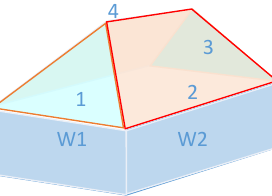
Figure 11. A building model with hip roof structure (the numbers 1 to 4 represent the individuals Pra1 , Pra2 , Pra3 and Pra4 . W1 and W2 are the individuals of class “Wall”).